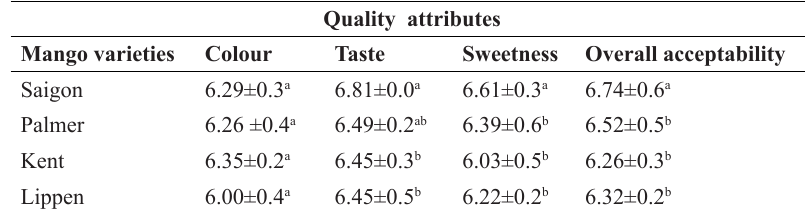
Table 5: Sensory attributes of juice produced from four mango varieties during